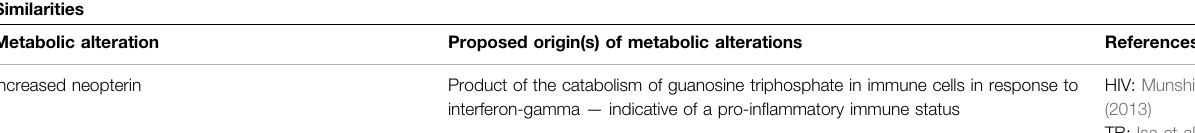
TABLE 4 | A comparison of the fi ndings of HIV infection and TB urinary metabolomics investigations a